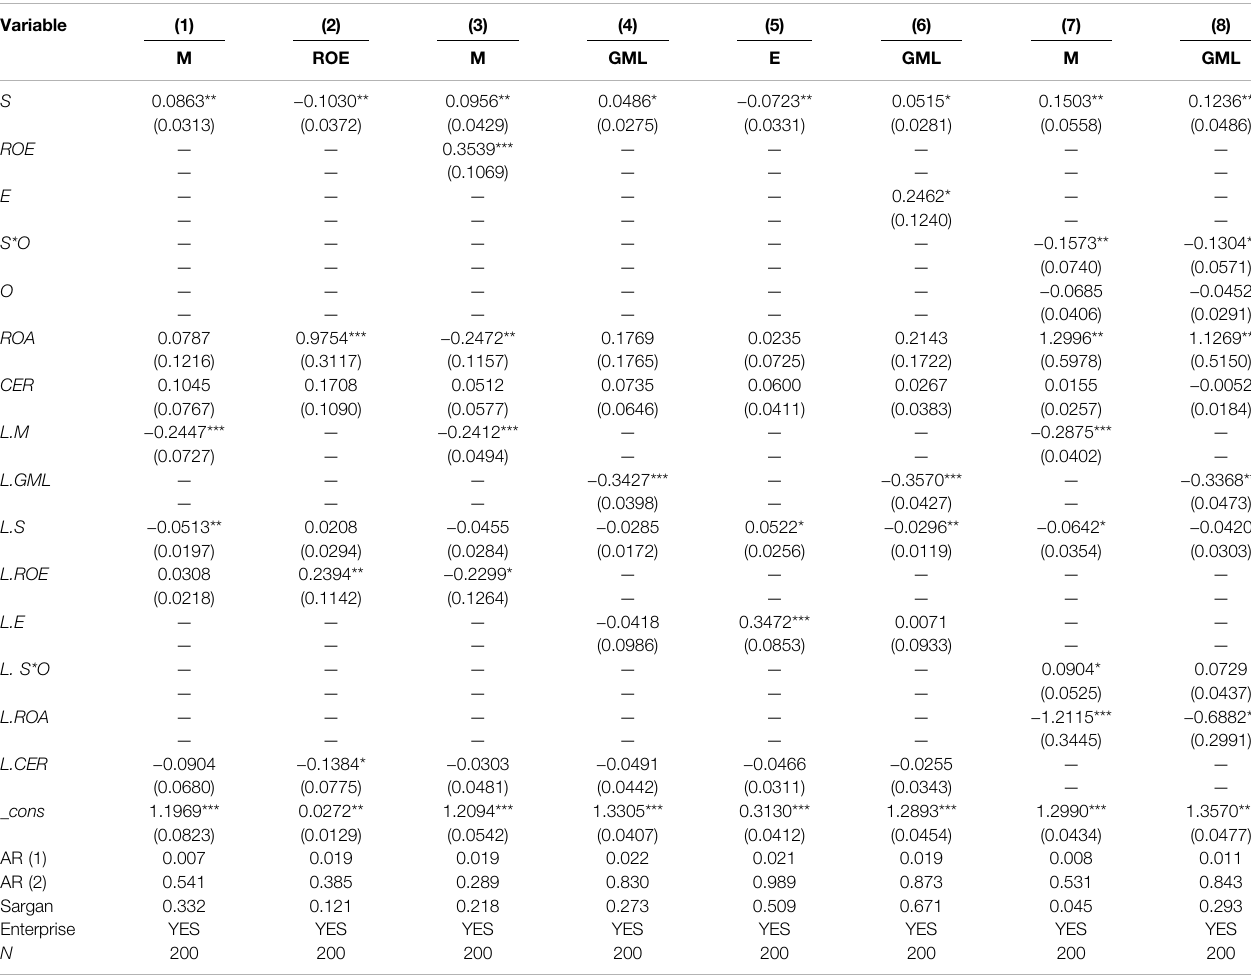
TABLE 9 | Robustness test